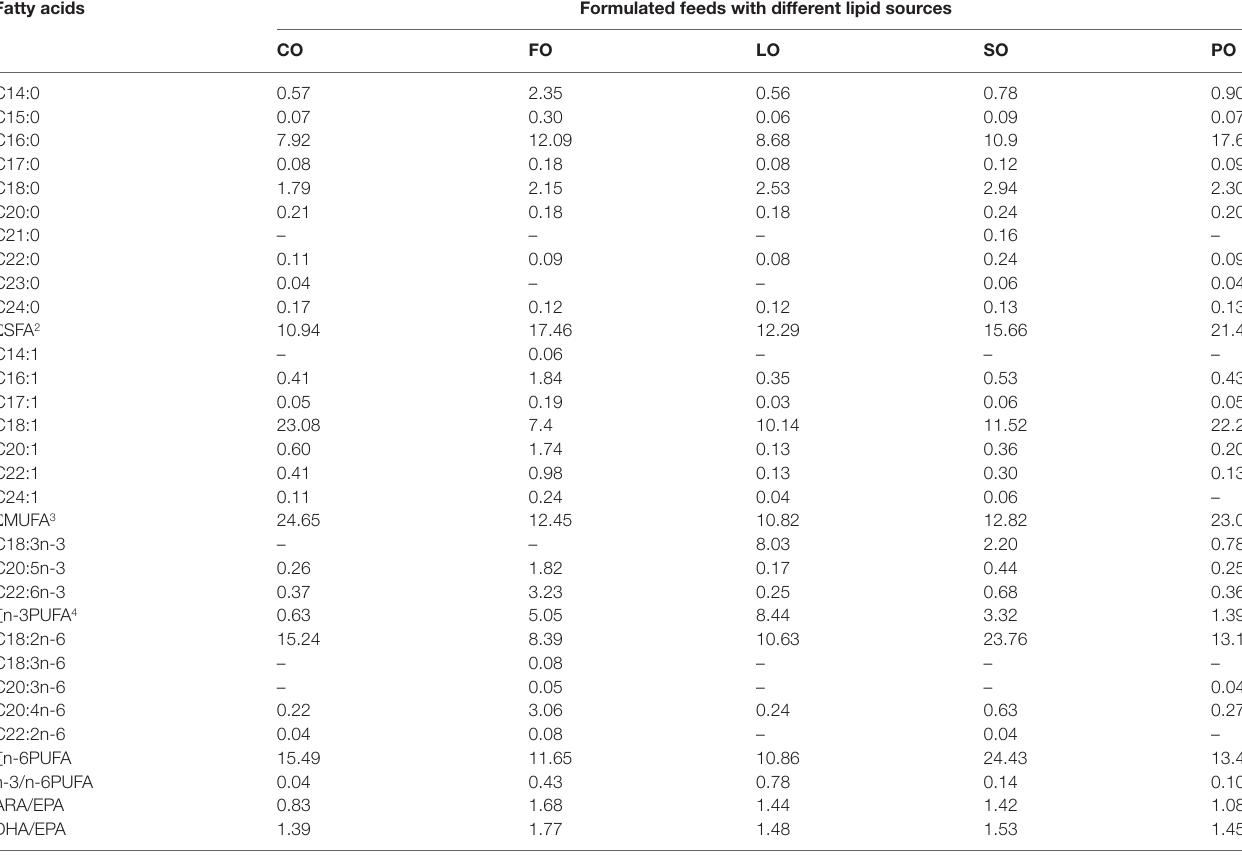
TABLE 2 | Fatty acid composition (g/kg dry matter) of formulated feeds 1 . Fatty acids Formulated feeds with different lipid